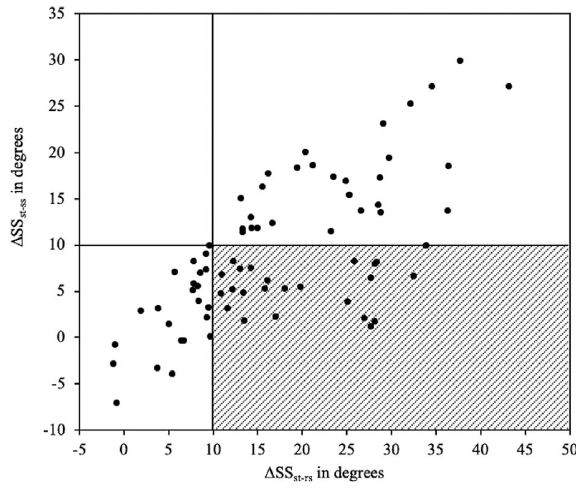
Figure 5. Scatterplot of spinopelvic mobility ( D SS) from the standing to the relaxed or straight seated position. Fifty-two patients with normal spinopelvic mobility in the relaxed seated position ( D SS st-rs > 10 (cid:1) ) are in the right quadrant. Twenty-four (46%) of them are classi fi ed as having a stiff spine ( D SS st-ss < 10 (cid:1) ) in the straight seated position (shaded area in the lower right quadrant), but they would not actually have stiff spines. D SS st-rs , change in sacral slope from standing to relaxed seated; D SS st-ss , change in sacral slope from standing to straight